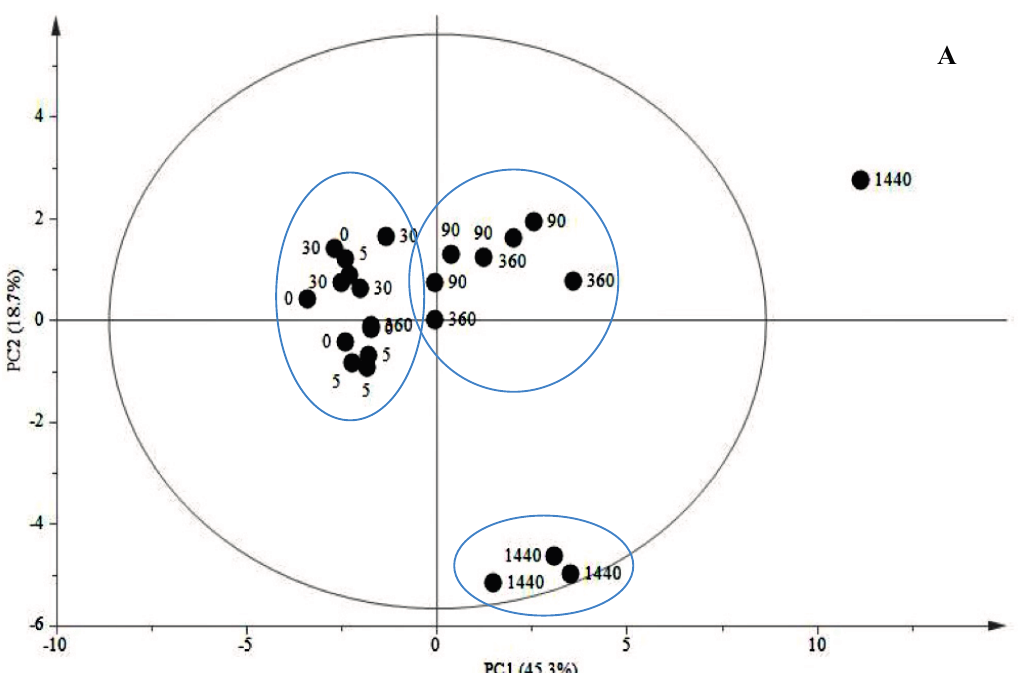
Figure 4. PCA analysis of scores and loadings plots of FA and TIA in cell suspensions of C. roseus after JA treatment. ( A ) PCA scores plot of FA and TIA profiles allowed the separation of data into three different clusters of events: first cluster (0–5–30 min after JA treatment); second cluster (90–360 min after JA treatment) and third cluster (1440 min after JA treatment). Variances accounted by PC1 and PC2 were 45.3% and 18.7%, respectively. ( B ) PCA loadings plot of PC1 vs. PC2 of FA and TIA profiles in the first cluster. ( C ) PCA loadings plot of the second cluster. ( D ) PCA loadings plot of the third cluster.